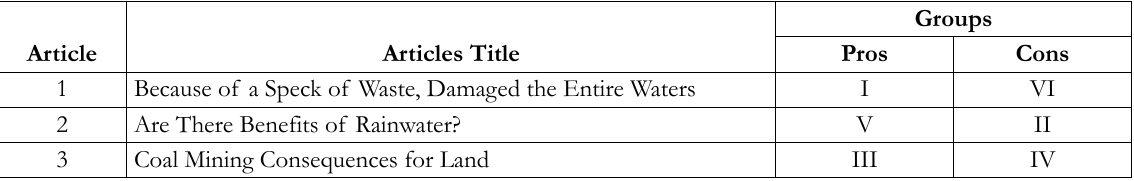
Table 1. Environmental Articles and Groups Distribution on Different Points of